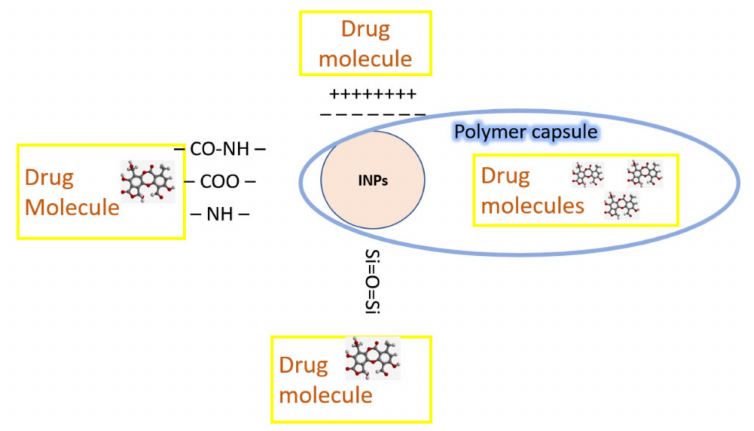
Figure 2. Drug conjugation with